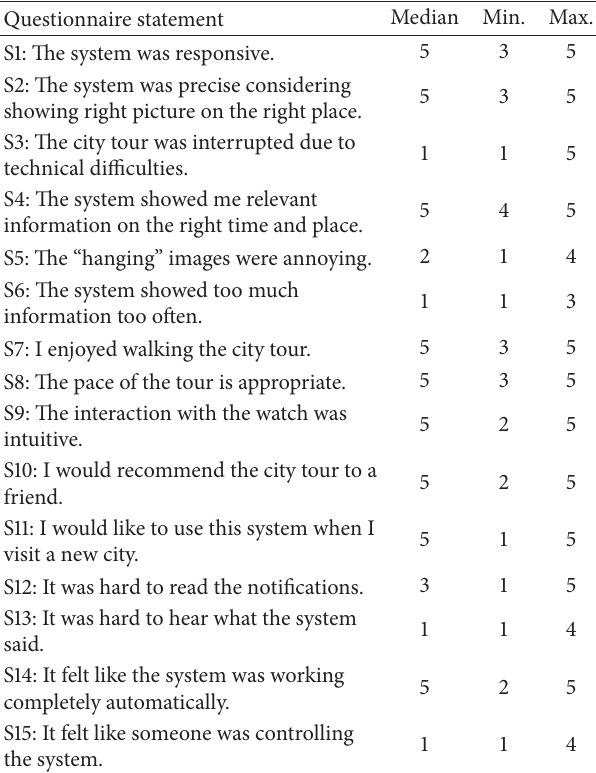
Table 2: Median and min. and max.